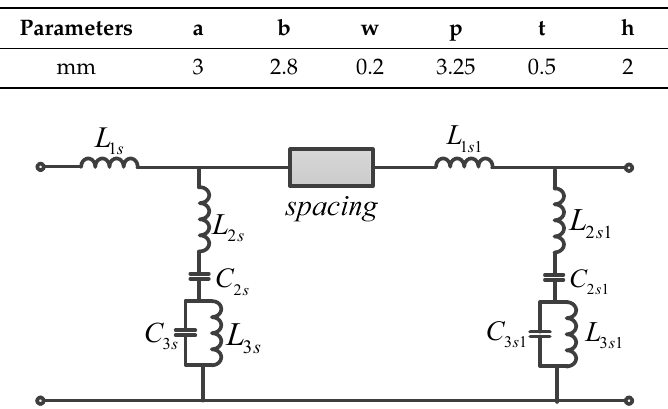
Figure 4. A 3D topology of harmonic suppression frequency selective metasurface element (FSMSE) (The blue part represents metal and the grey represents substrates). Table 2. Parameters of the FSSs shown in Figure 4.